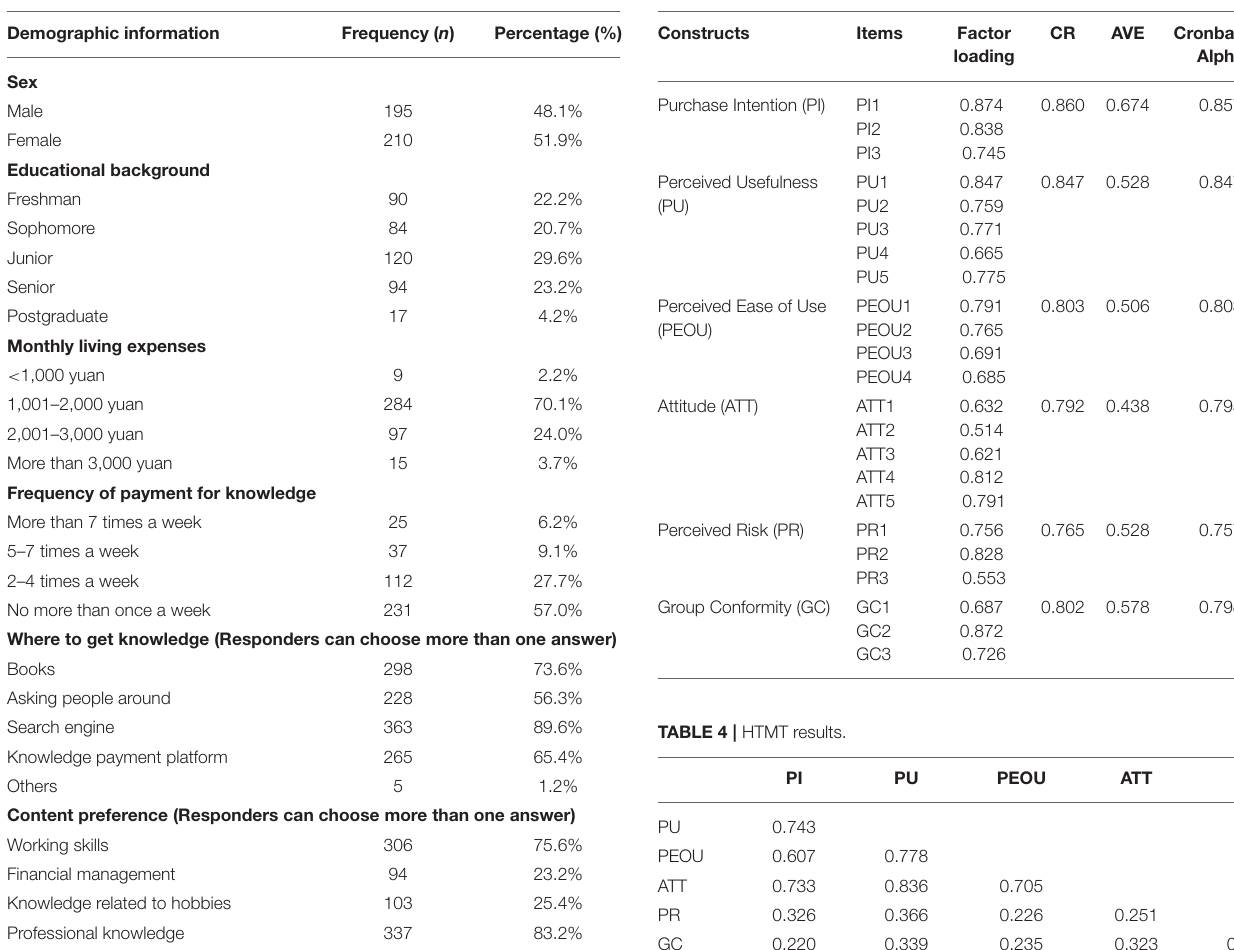
TABLE 2 | Demographic information. TABLE 3 | Construct reliability and convergent validity.